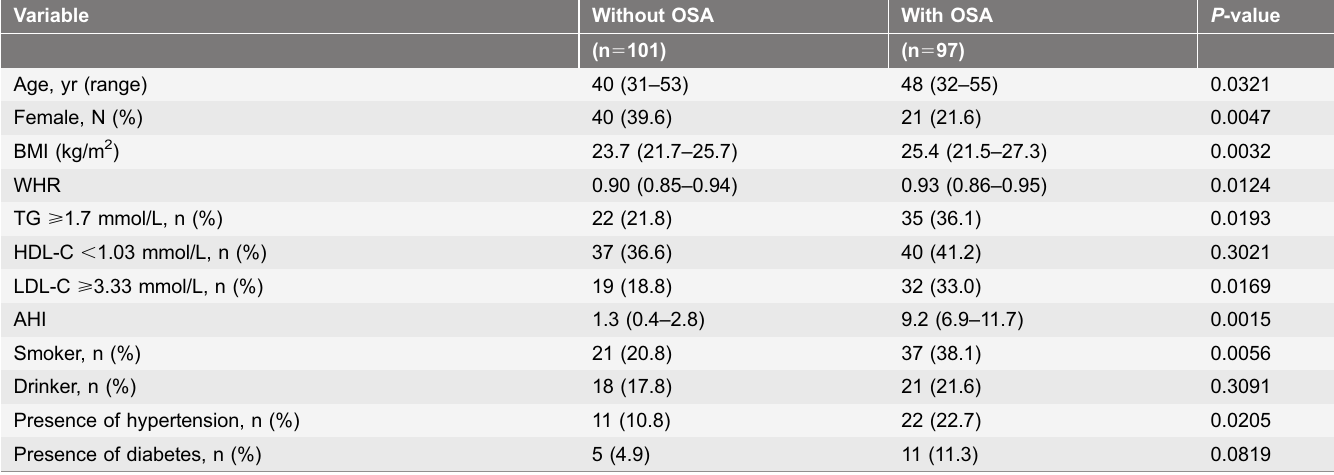
Table 2. Baseline data of the study